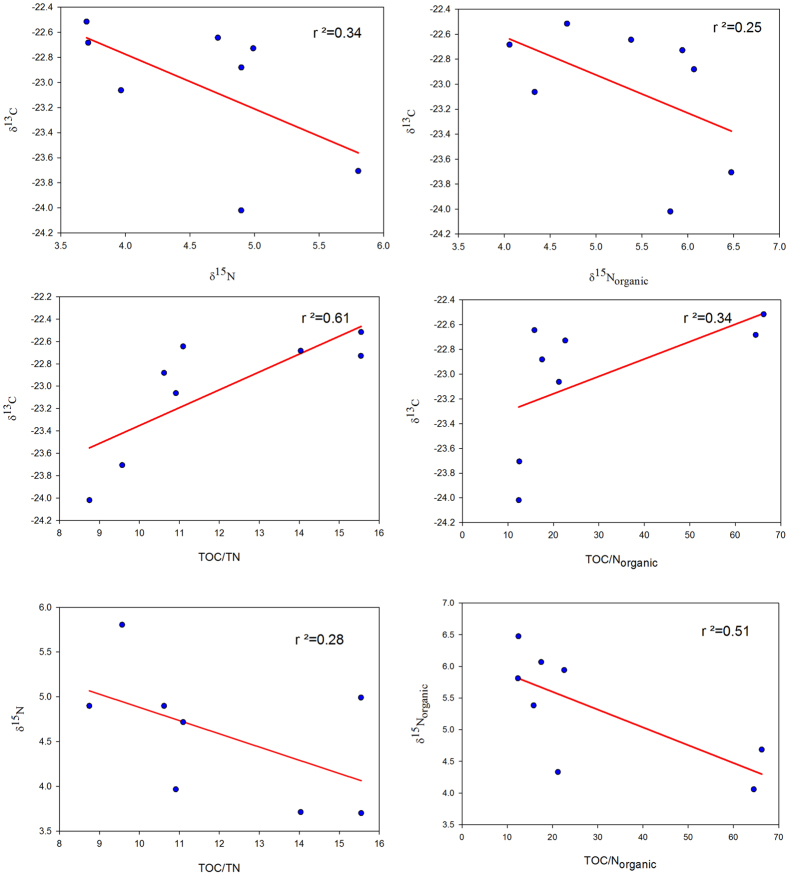
δ15N, δ15Norg, TOC/TN and TOC/Norg versus each other and δ13C.Negative correlation between carbon and nitrogen isotopic composition of SOM and positive correlation between carbon isotopic composition and C/N ratio of SOM at Kongsfjorden is due to unusually more depleted marine organic matter.